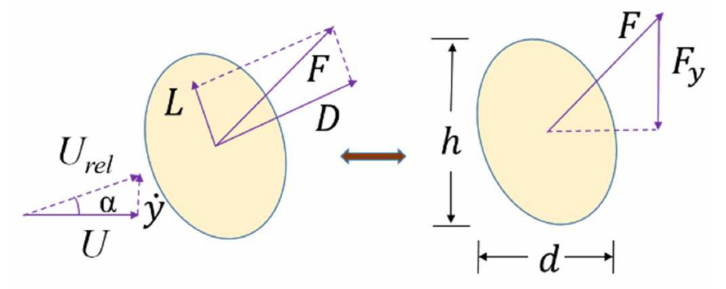
Figure 2. A bluff body subjected to